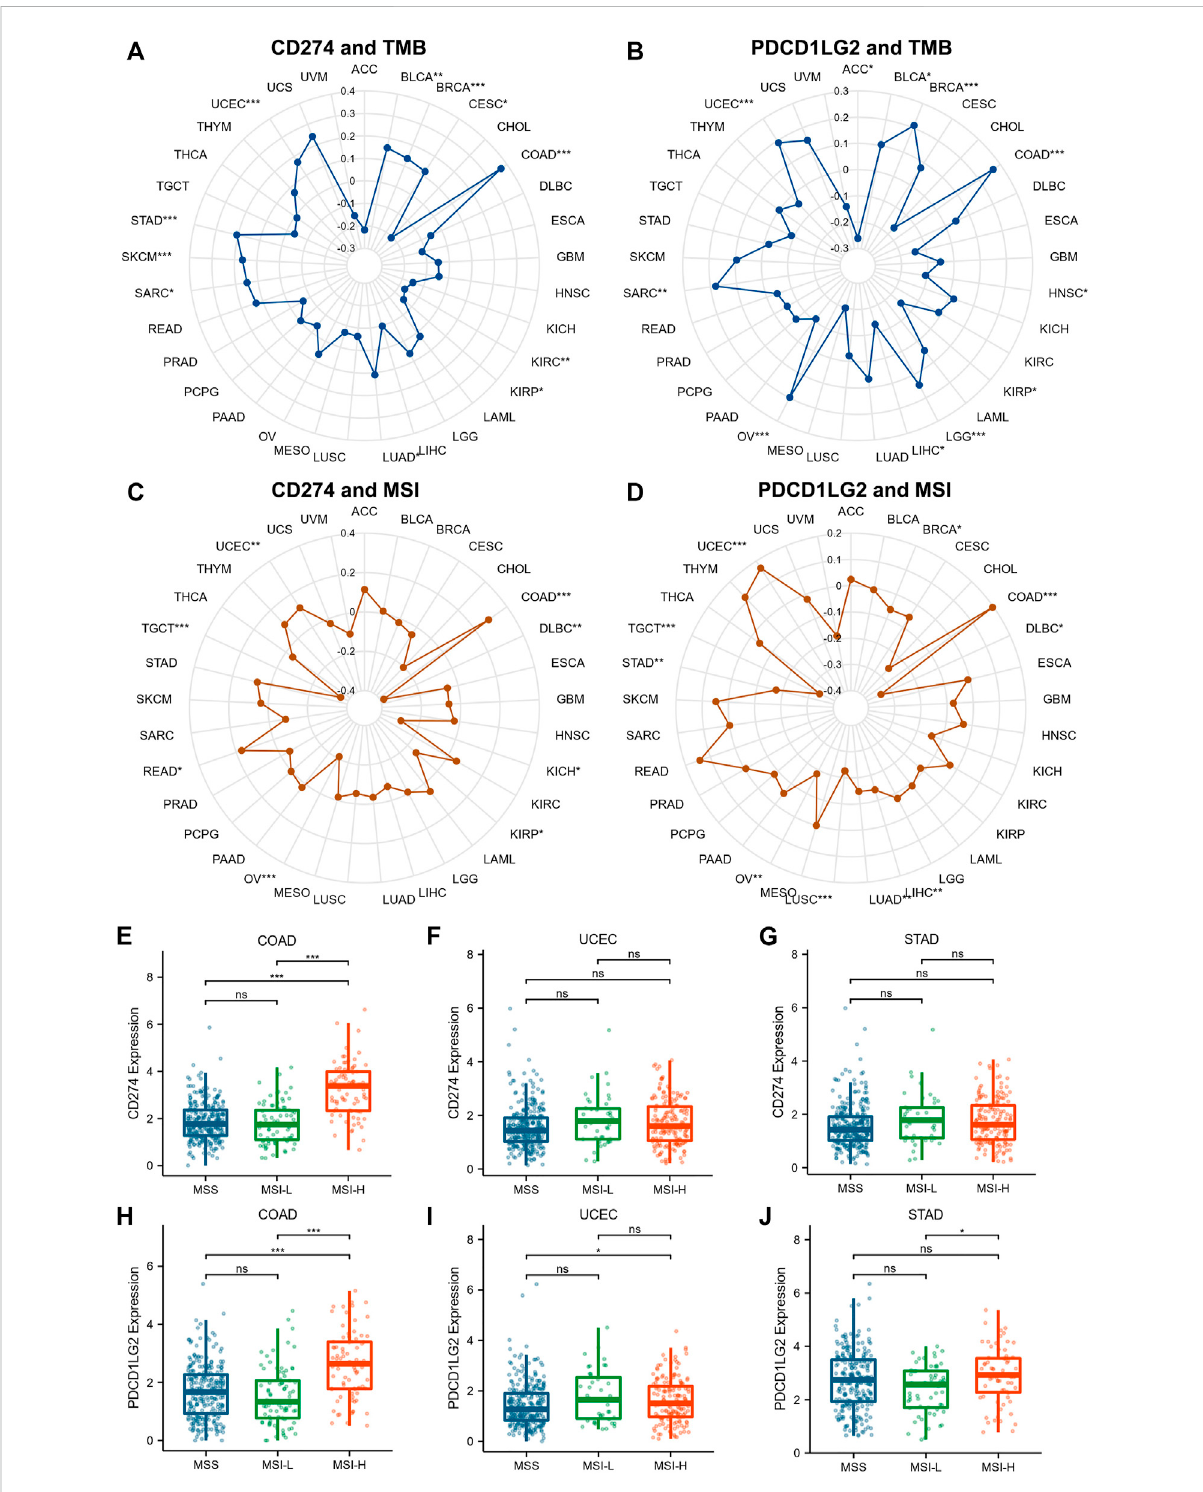
FIGURE 9 Correlations between CD274/PDCD1LG2 levels and TMB and MSI. The radar diagram indicates correlations between CD274/PDCD1LG2 levels and (A,B) TMB and (C,D) MSI, with black values representing correlation coef fi cients. Box plot showing the association between CD274/ PDCD1LG2 levels and MSI status in (E,H) COAD, (F,I) UCEC, and (G,J) STAD (* p < 0.05, ** p < 0.01, *** p <